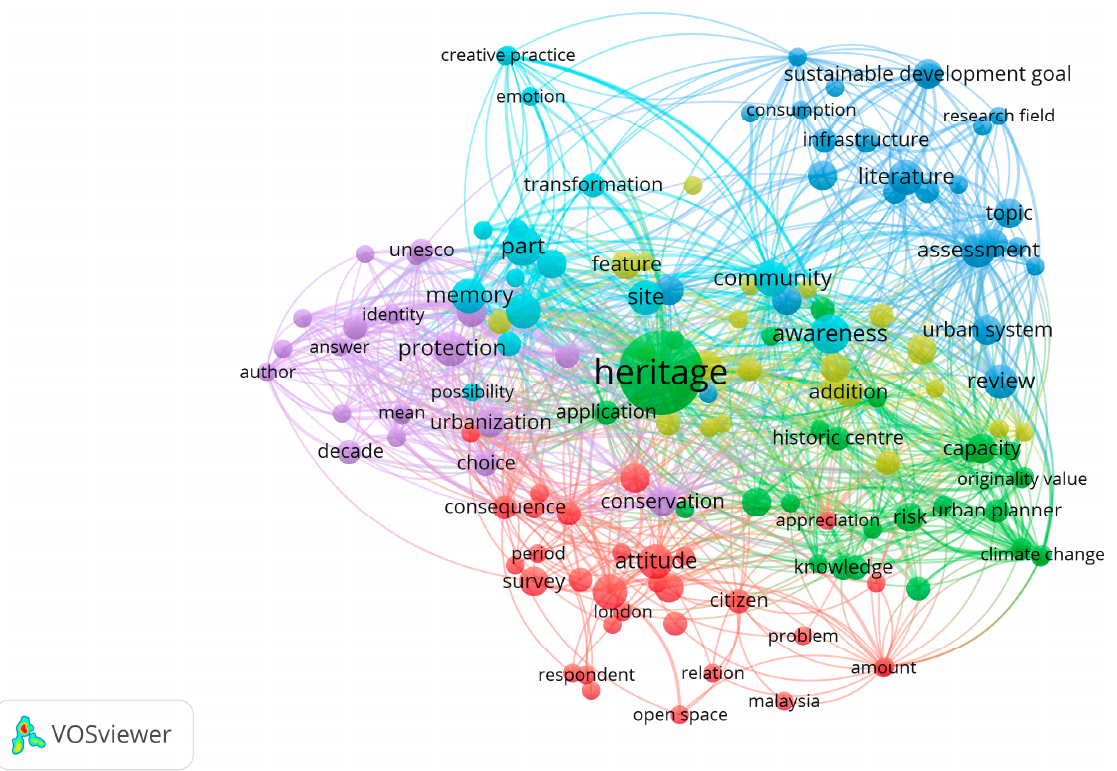
Figure 5. The term co-occurrence map (the node size is proportional to the number of terms).